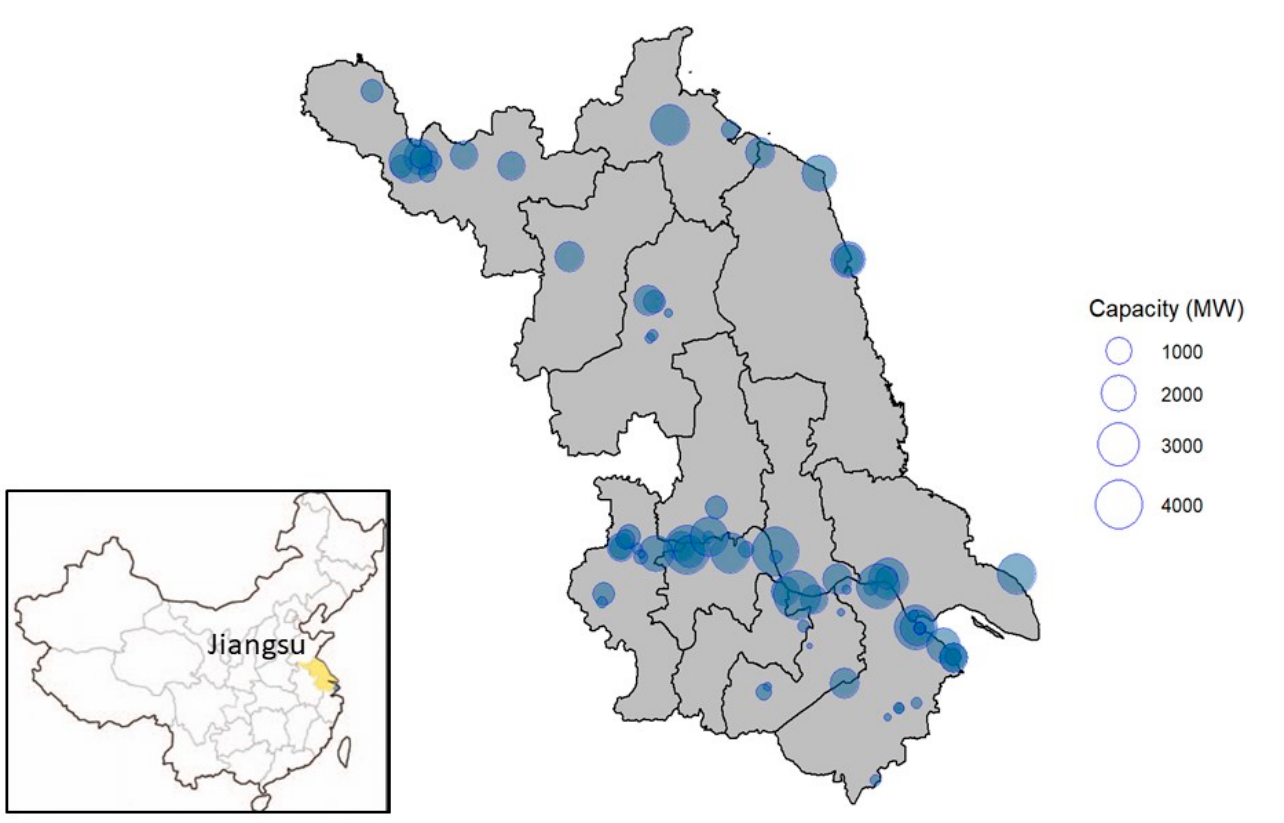
Figure 2. Location and capacity (unit: MW) of coal power plants in Jiangsu Province.